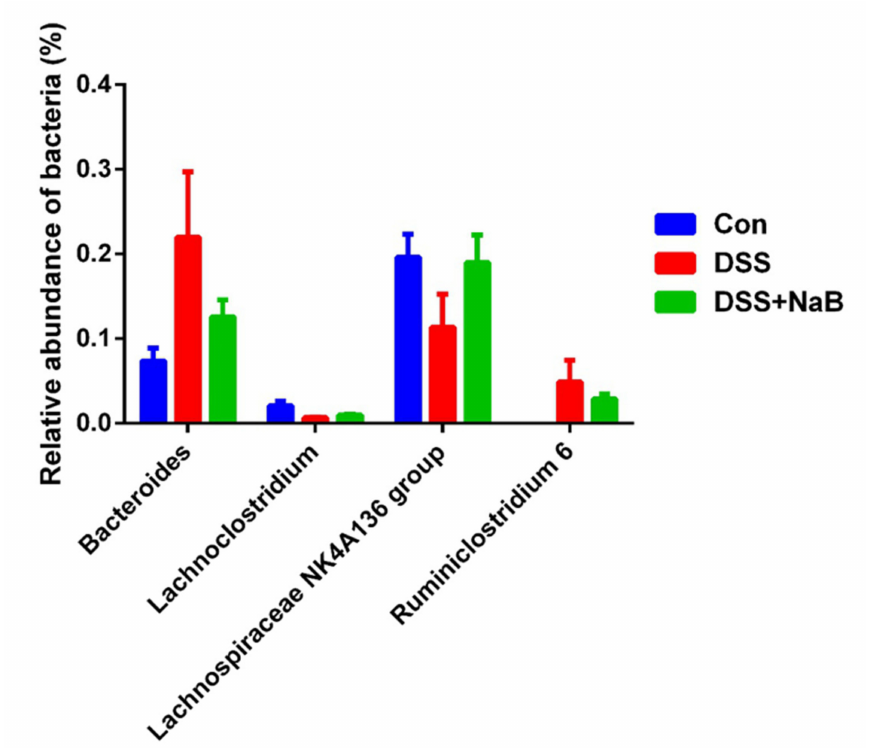
Figure 5. Relative abundance of selected taxa at the genus level. Data are shown as the means ± SD. Di ff erent letters represent statistically significant di ff erences among di ff erent treatment groups ( p <